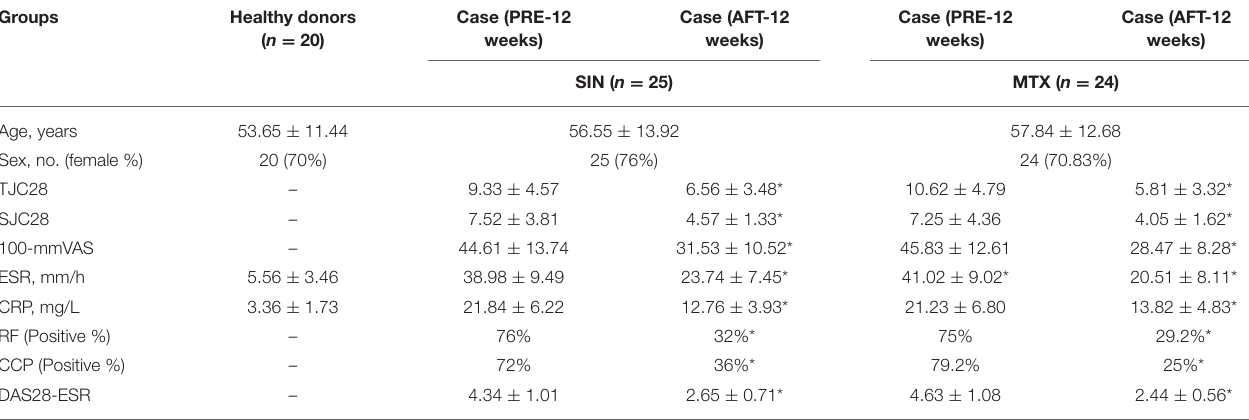
TABLE 2 | Baseline characteristics of the 20 healthy donors and clinical, biological and physiological indicators and therapeutic response after before and after treatment in RA patients. Groups